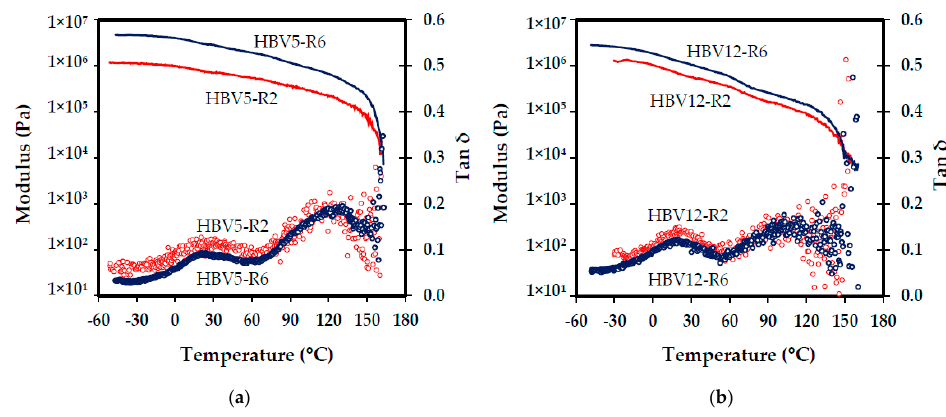
Figure 6. Effect of cooling rate (red and blue symbols/lines correspond to rates of 2 °C/min and 6 °C/min, respectively) on storage modulus (solid-line curves) and loss tangent (circle-marker curves) of PHBV scaffolds containing 5 wt % ( a ) and 12 wt % ( b ) of HV units.